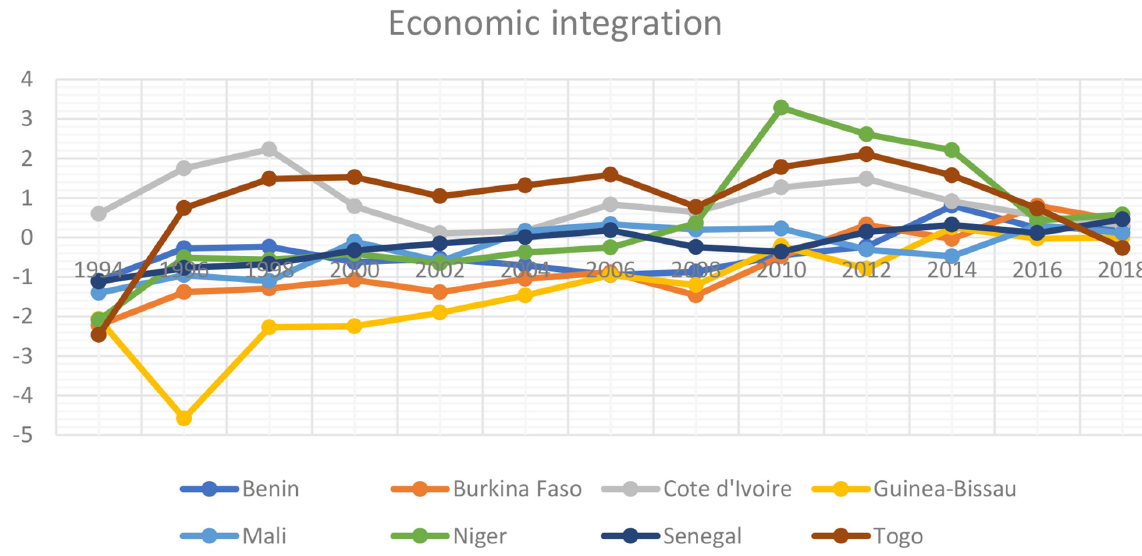
Fig. 2. Regional economic integration index.